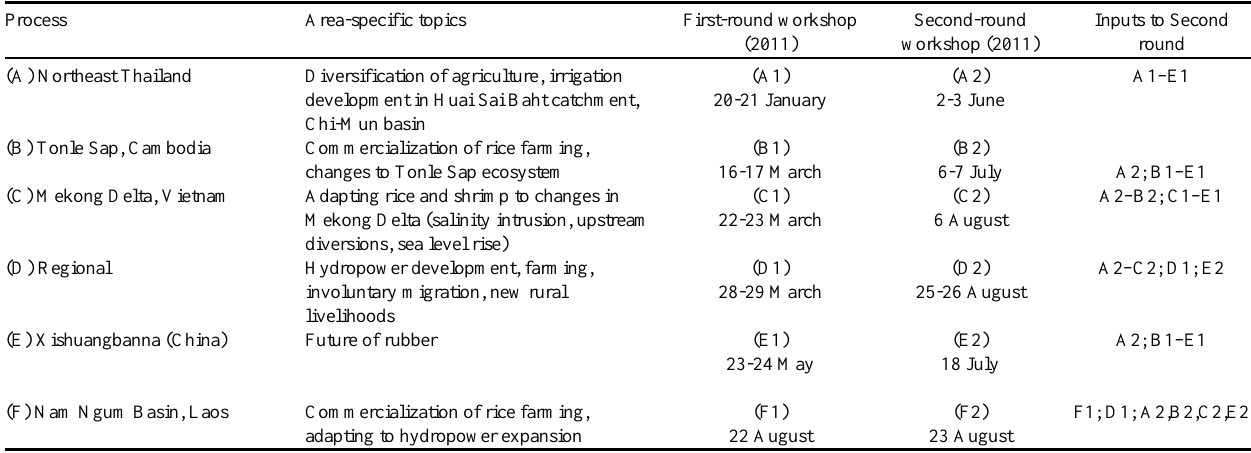
Table 3 . Iterative, cross-scale design of Mekong scenario